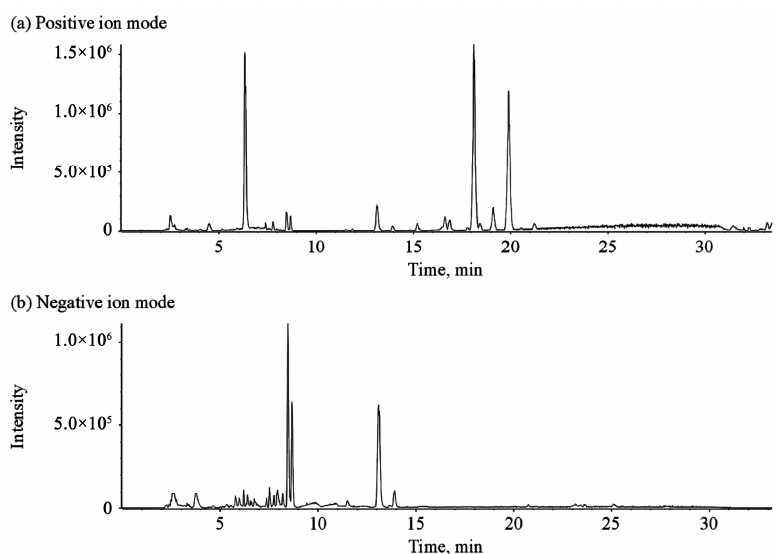
Figure 2. The basic peak chromatograms of Ganpu tea extract (GTE) in positive ( a ) and negative ( b ) ion modes.